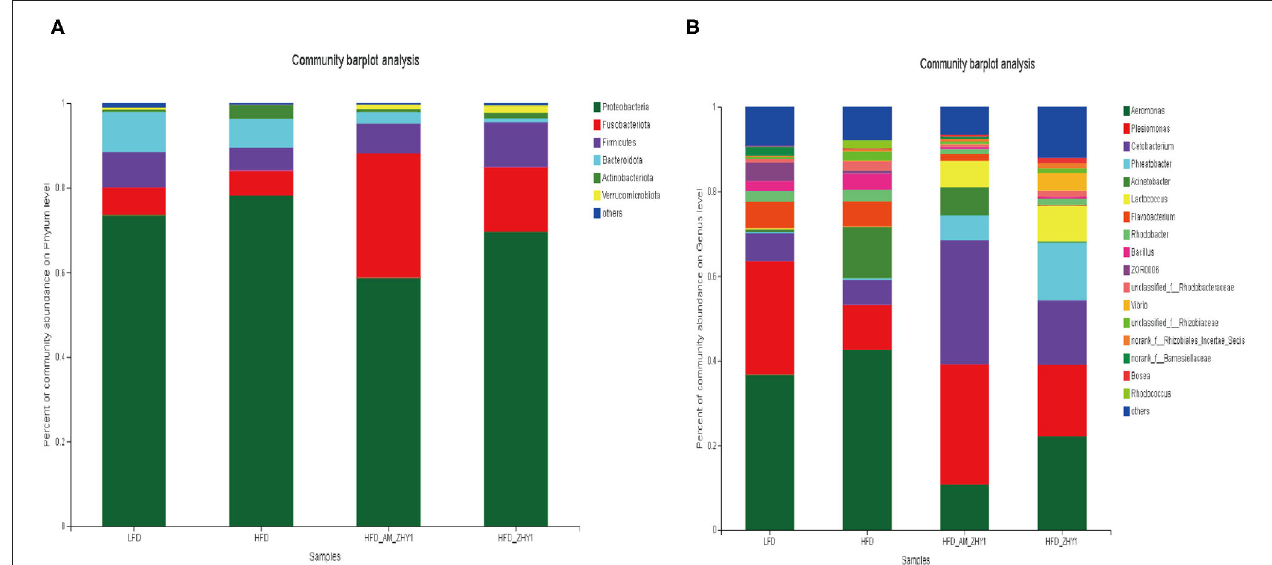
FIGURE 8 | The effect of different diets on the relative abundance of intestinal flora at the phylum in zebrafish (A) and the genus (B) level. LFD, basal diet; HFD, high-fat diet; HFD_AM_ZHY1, supplement 10 8 cfu/g AM-ZHY1 based on a high-fat diet; HFD_ZHY1, supplement 10 8 cfu/g ZHY1 based on a high-fat diet.